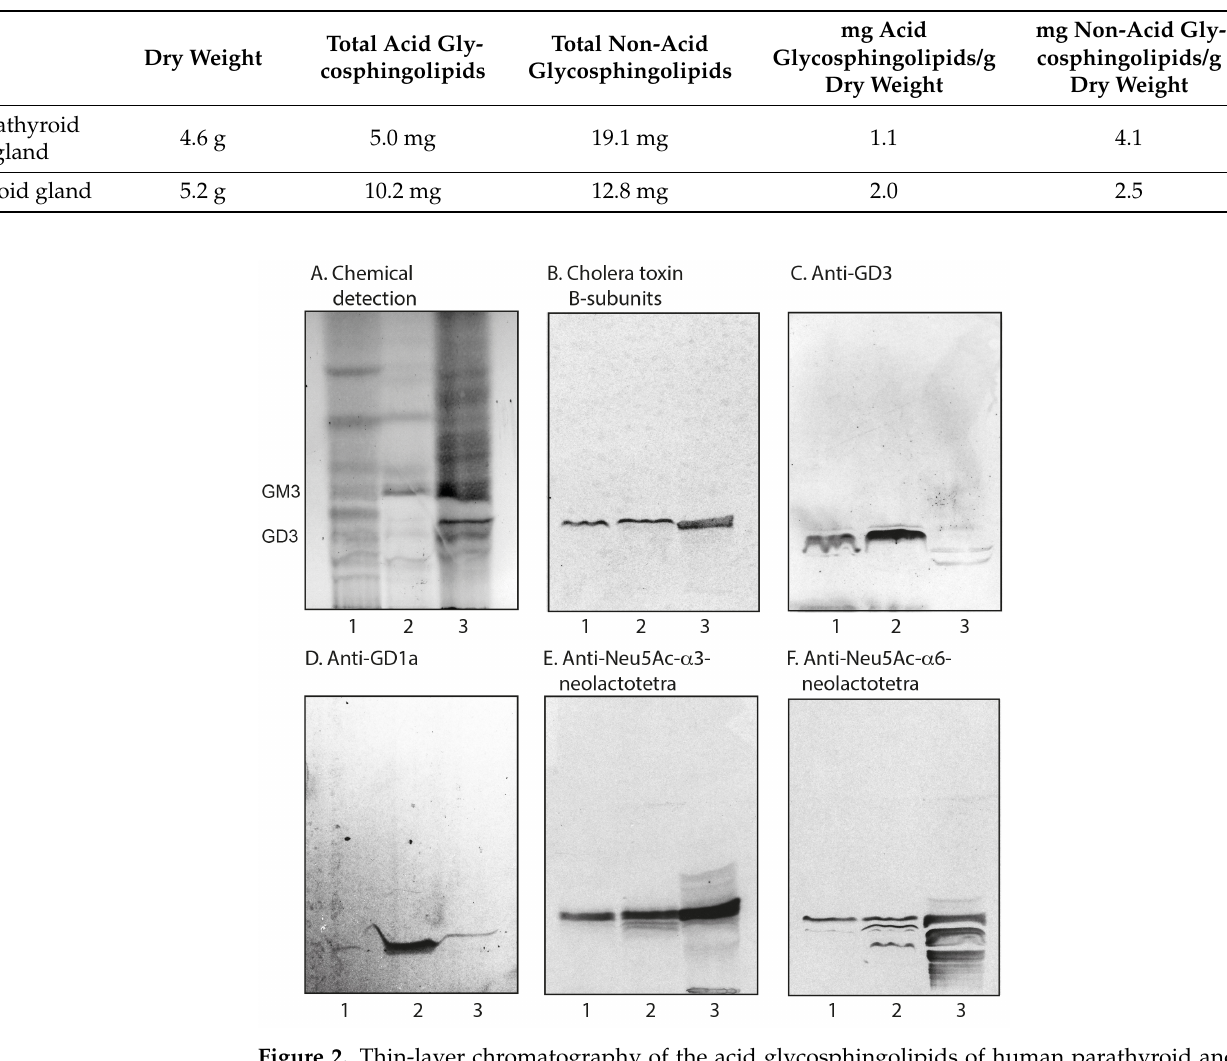
Table 1. Glycosphingolipid preparations.